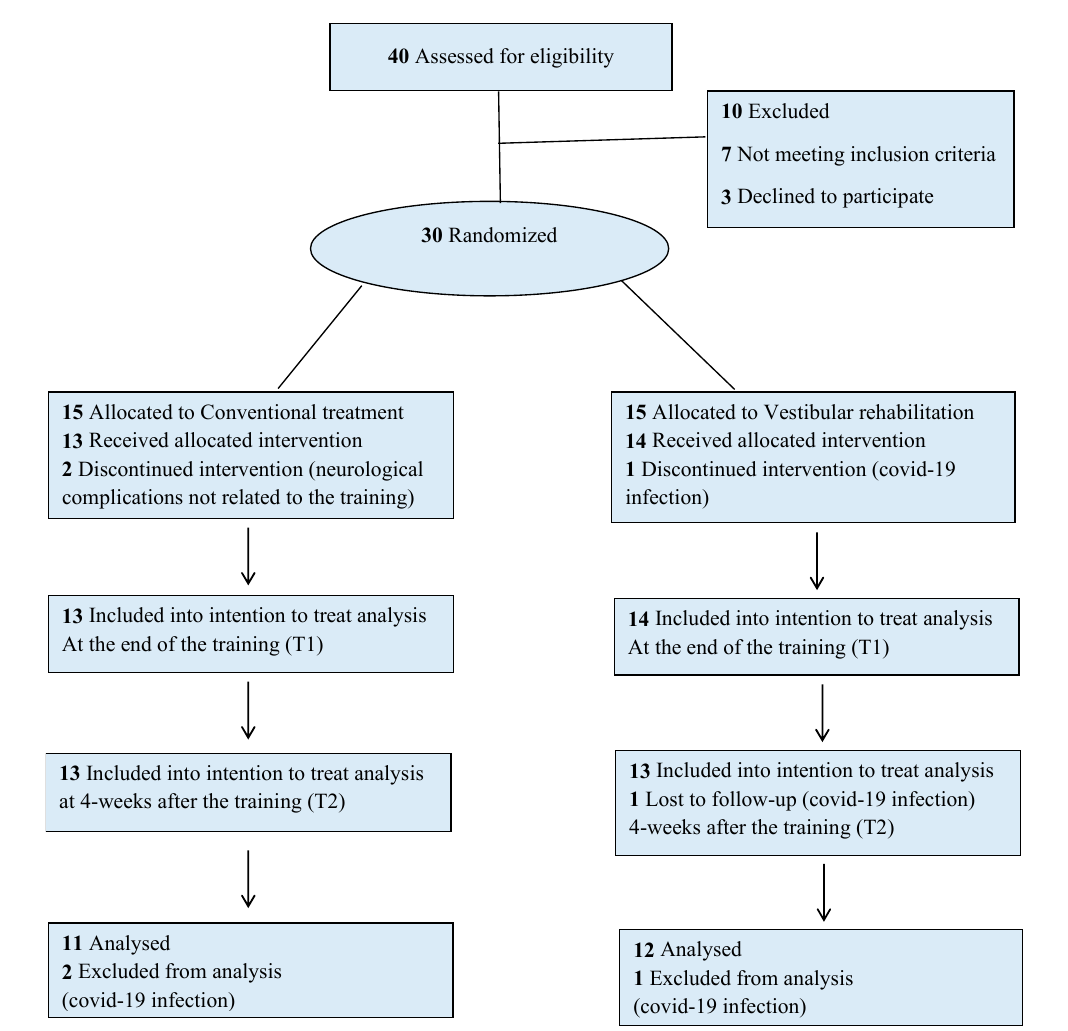
Figure 1. Flow diagram for randomization of patients with severe traumatic brain injury enrolled in the study.